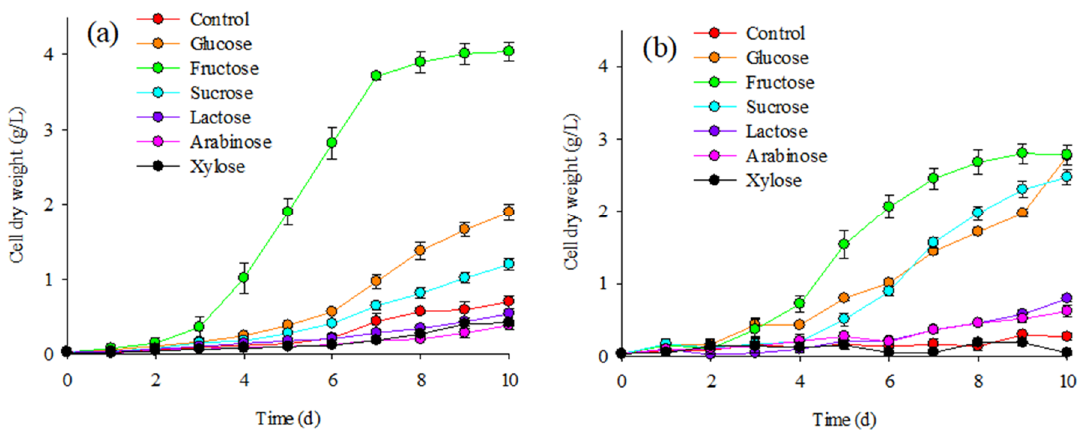
Figure 1. Photoautotrophic and mixotrophic growth of Coelastrella sp. KKU-P1 with various carbon sources under visible light illumination from ( a ) fluorescent or ( b ) light-emitting diode lamps. Average values of cell concentration expressed as cell dry weight were presented along with the standard deviation values of three